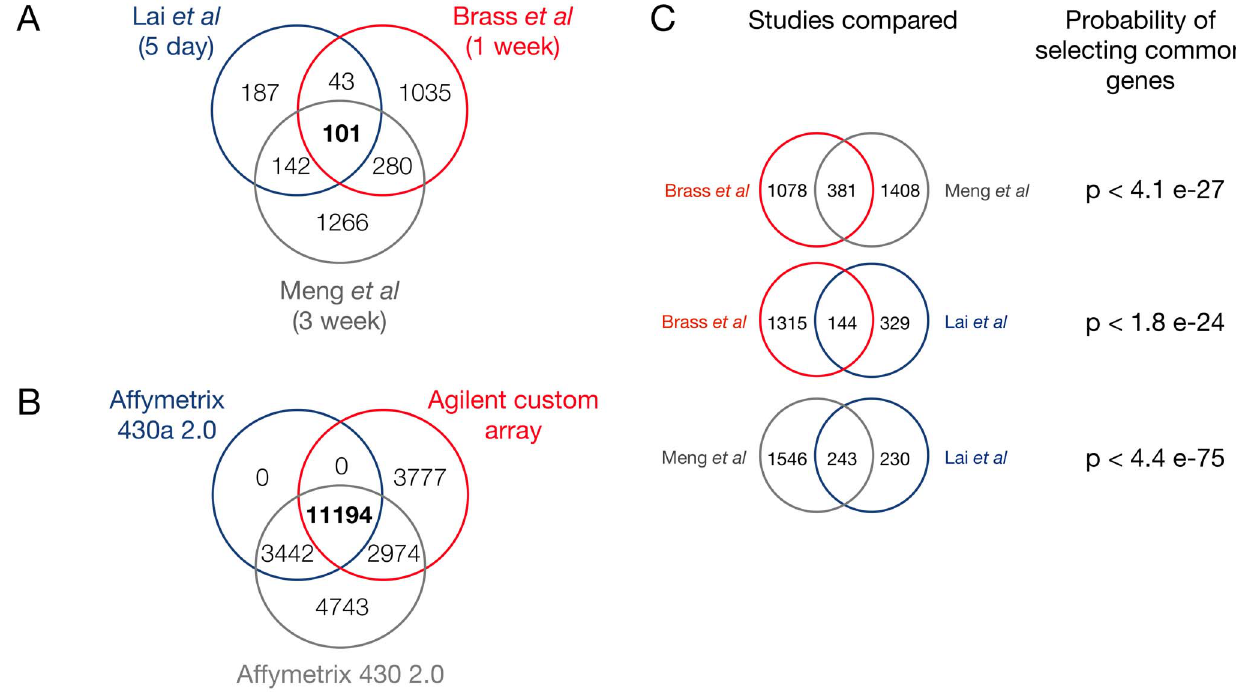
Figure 1. Comparison of 3 identified studies of murine inhaled endotoxin exposure used to generate gene signature . 1a. Common intersect of differentially regulated genes (endotoxin vs. control exposure) identifies a gene signature for endotoxin exposure. 1b . Common intersect of arrays used in each studies represents a background distribution to identify the statistical significance of the gene signature. 1c . 2-way hypergeometric tests to identify statistical significance of gene signature.